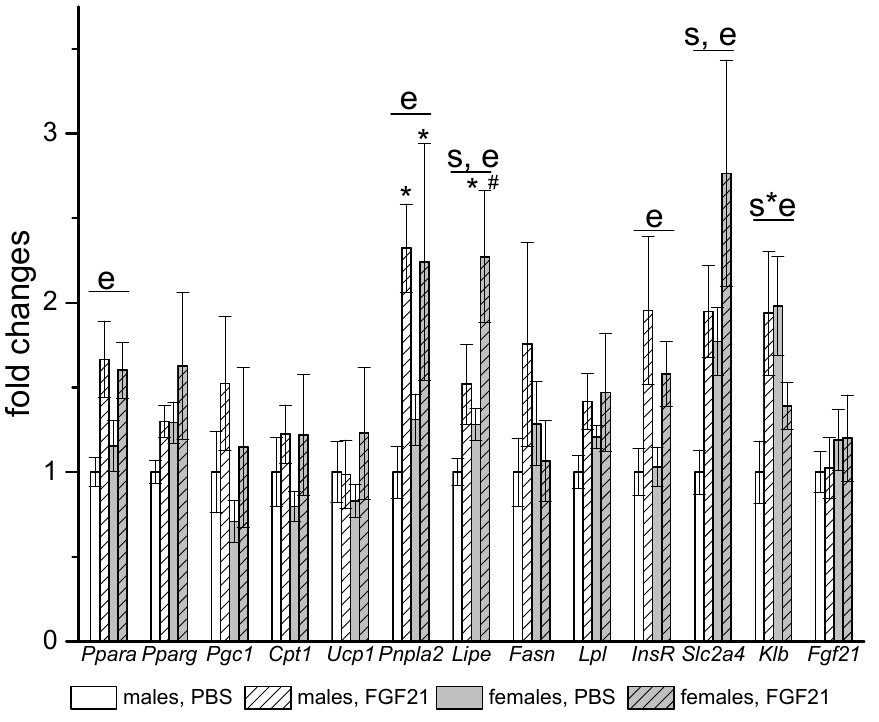
Figure 6. Influence of FGF21 administration on visceral WAT gene expression in obese A y male and female mice. Data are presented as mean ± SE. Mice were administered FGF21 for 7 days. Significant influence ( p < 0.05) of factors “e” (administration of PBS or FGF21), “s” (sex), and “s*e”, two-way ANOVA are indicated in the plot. Sex differences in gene expression and gene expression response to FGF21 administration were observed in muscles (Figure 7). In PBS-treated mice, muscle mRNA levels of Ucp3 and Irs1 were higher in females. FGF21 administration increased mRNA levels of Cpt1 and Irs1 and at the level of tendency ( p = 0.06, nonparametric Mann— Whitney U test) mRNA levels of Insr and Slc2a4 only in males.